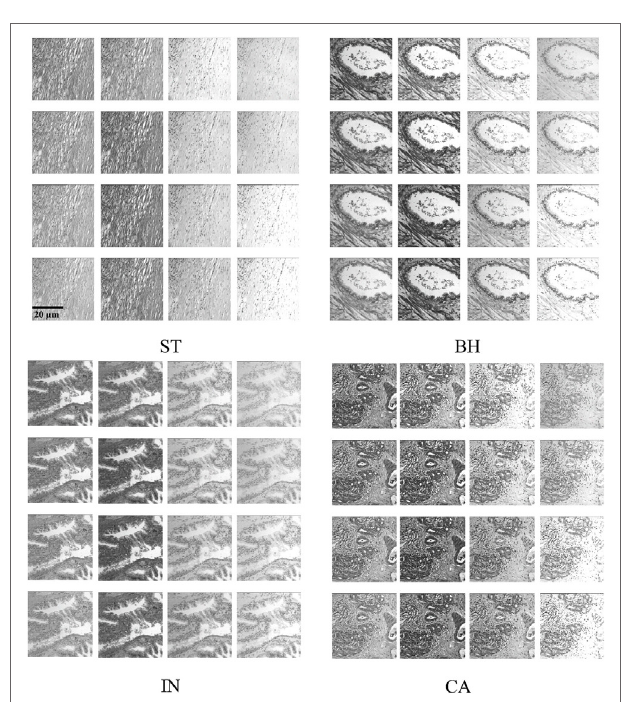
FigUre 2 | Example of histopathological multispectral images ( × 40 objective magnification; scale bars = 20 µm) of colorectal cancer samples (ST, stroma; BH, benign hyperplasia; IN, intraepithelial neoplasia; CA, carcinoma). Sixteen multispectral bands were acquired in the wavelength range of 500–650 nm, with 9.375 nm steps between successive bands (23).